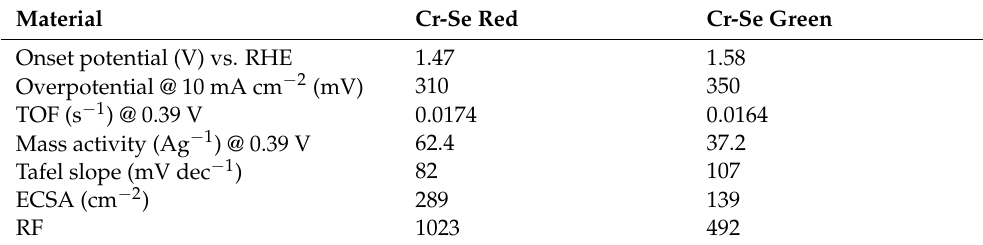
Table 1. Electrocatalytic parameters compared in Cr-Se catalytic systems.